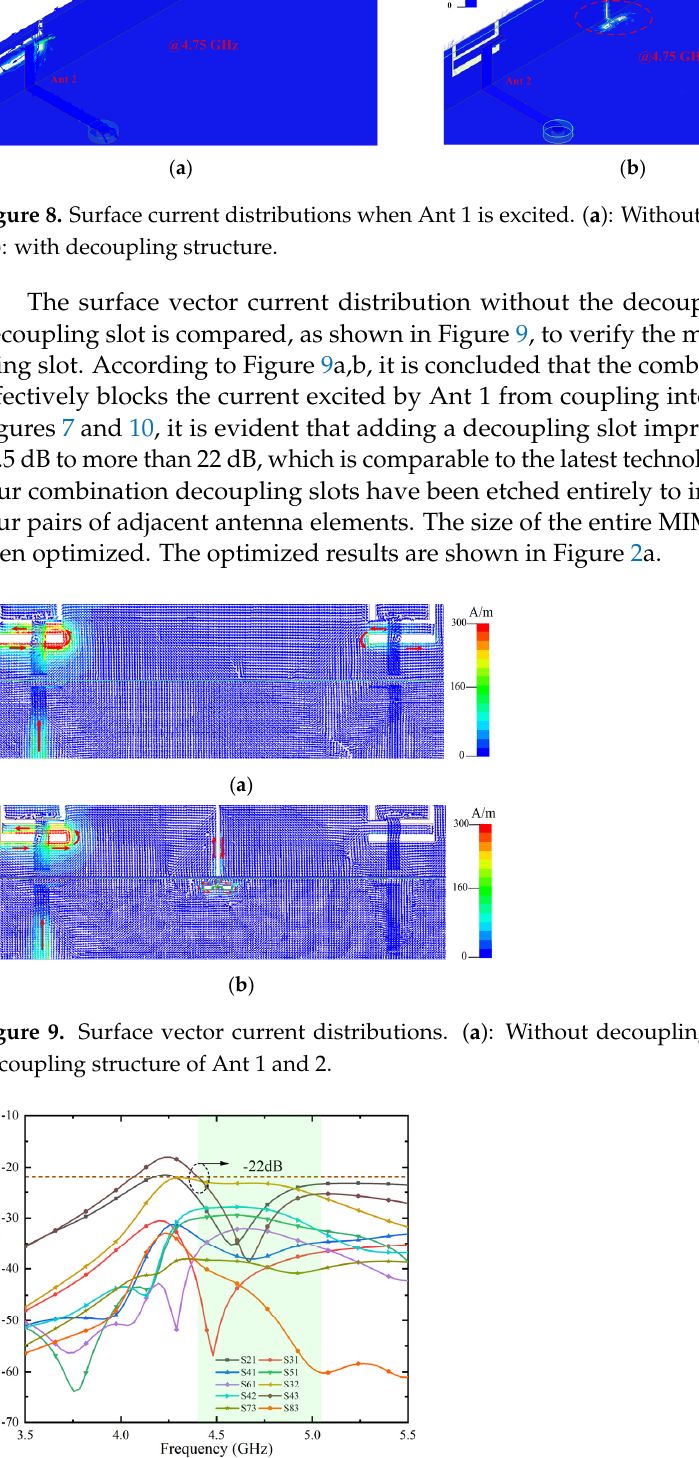
( d ) Figure 11. Photographs of the fabricated MIMO antenna system. ( a ): Front view, ( b ): back view, ( c ): long side view, and ( d ): short side view.